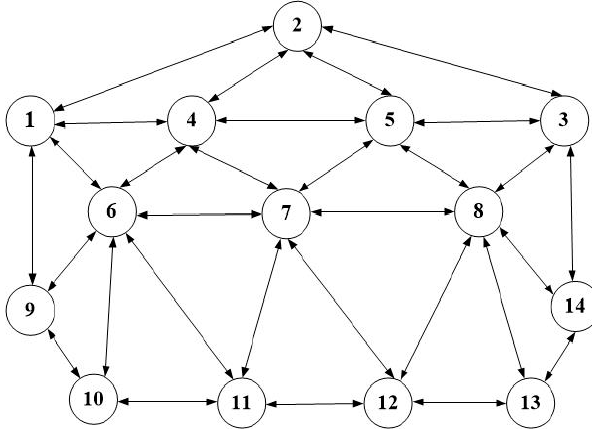
Figure 11. The 14-node topology.